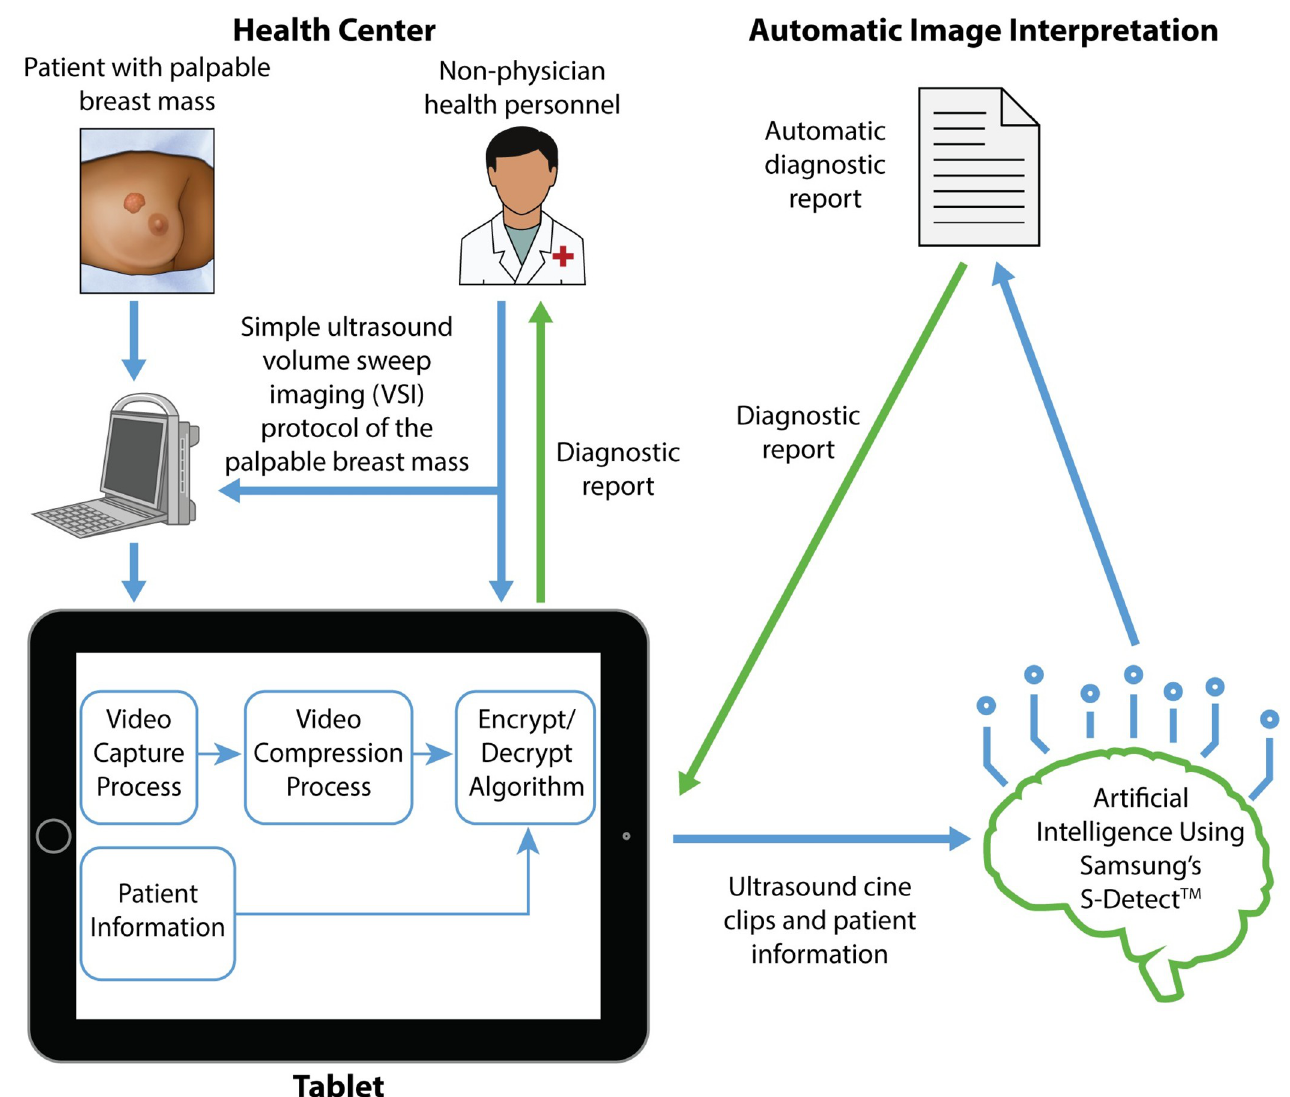
Fig 4. Proposed Model for Integration of Breast VSI and Artificial Intelligence. Schematic demonstrating the integration of VSI and artificial intelligence. In this model, a patient presenting with a palpable breast mass would be scanned by an individual with a few hours of ultrasound training using the VSI protocol. Imaging acquisitions would be funneled into artificial intelligence software that outputs a diagnostic report. The diagnostic report would then be available for the health center and patient. This would result in rapid and automated diagnosis without a radiologist or a sonographer.